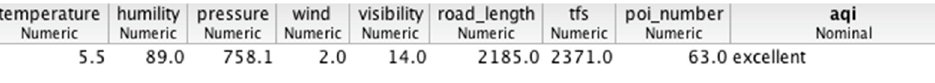
Figure 5. Dataset structure.